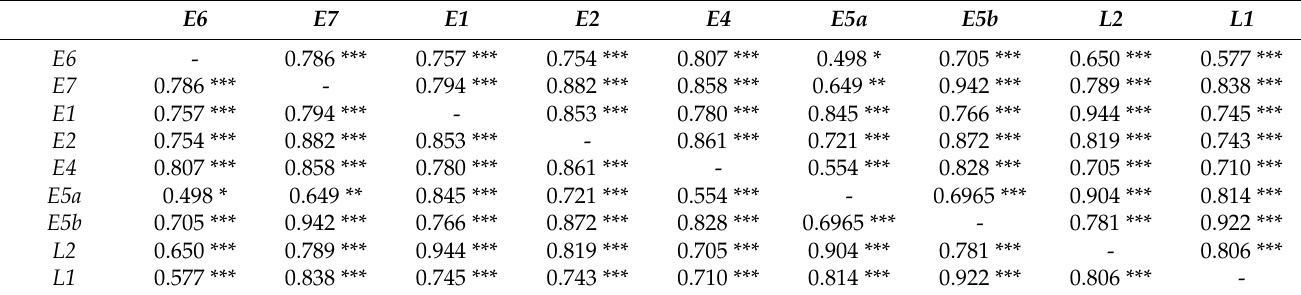
Table 4. Correlation coefficients between the expression levels of the 9 viral mRNAs in HPV-6-related